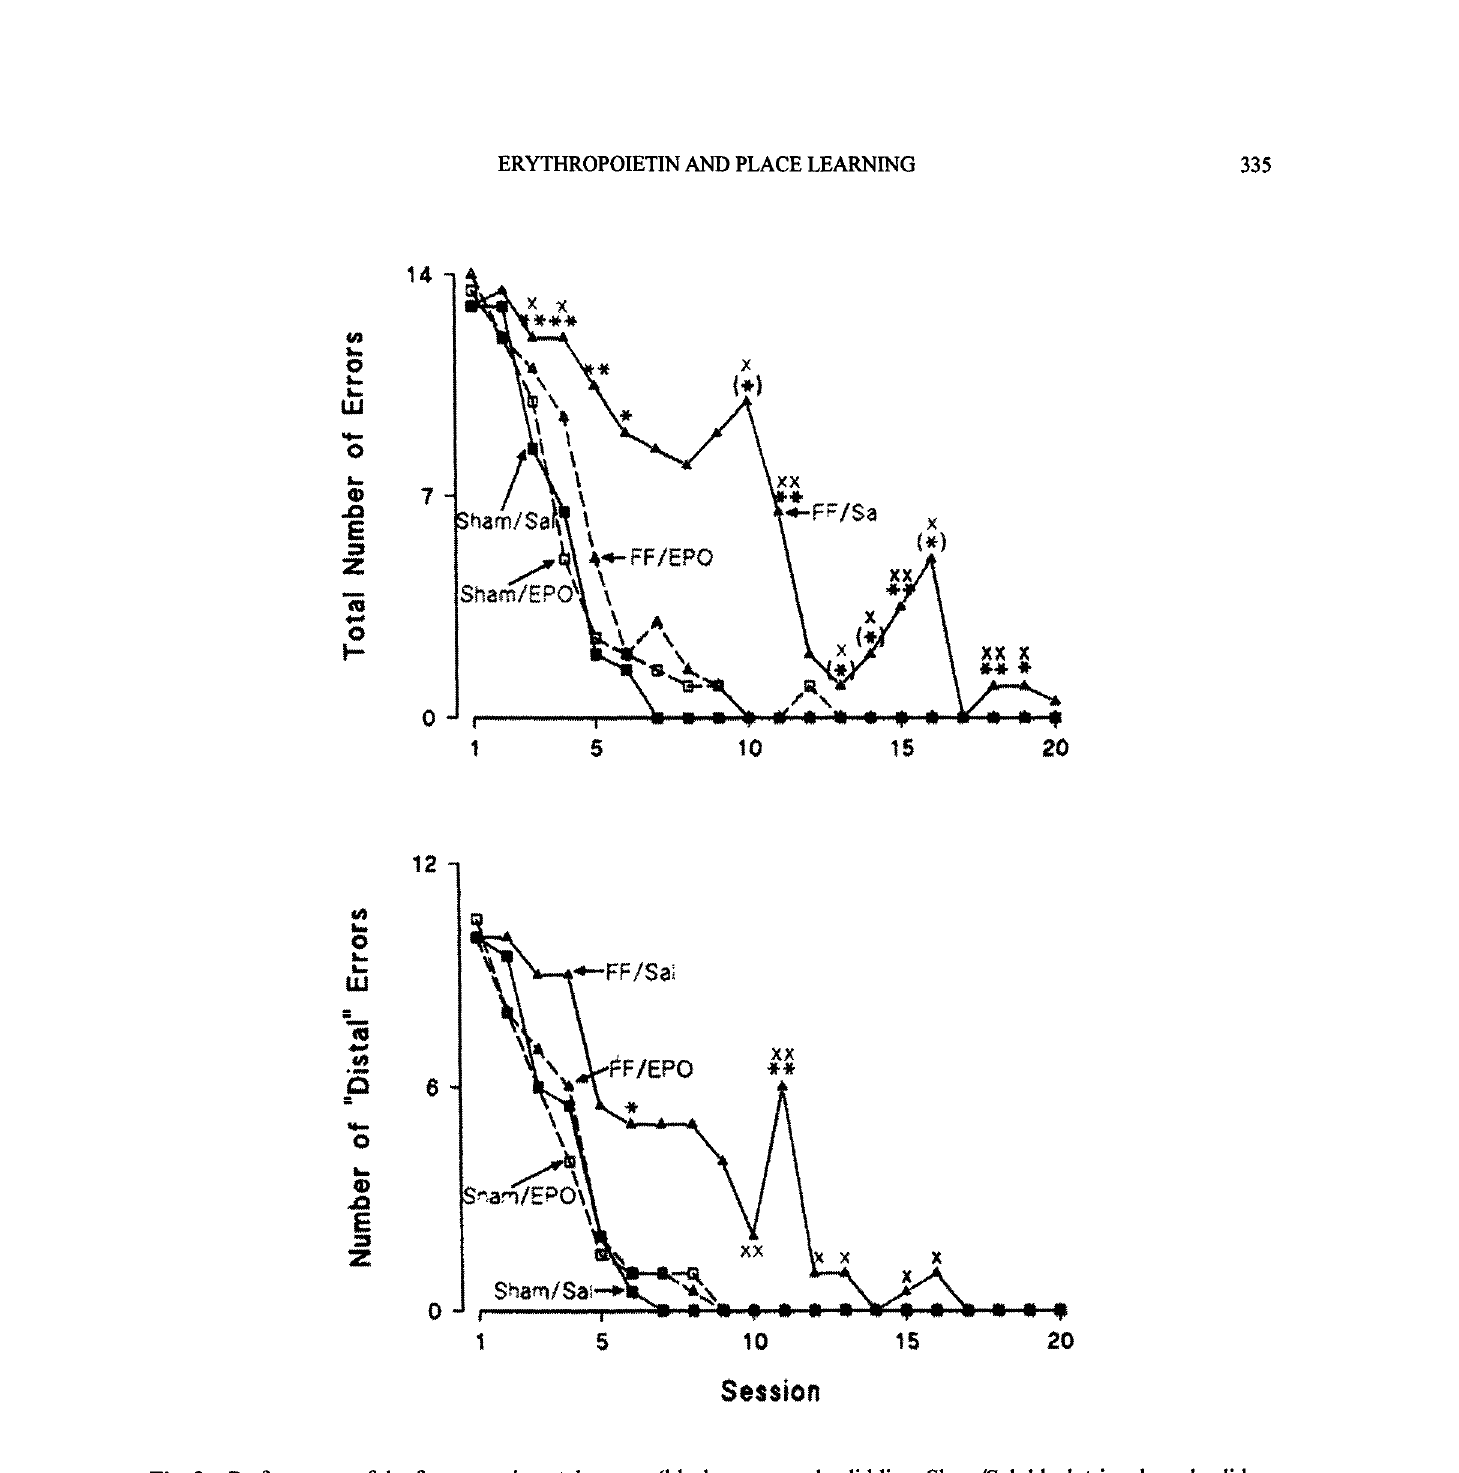
Fig. 2: Performance of the four experimental groups (black square and solid line: Sham/Sal; black triangle and solid line: FF/Sal; open square and broken line: Sham/EPO; open triangle and broken line: FF/EPO) on the 20 sessions of the place learning acquisition period. Values are given as medians. *: Significantly (p<0.05) different from the Sham/Sal group. (*): Significantly (p<0.05, one-tailed) different from the Sham/Sal group. **: Significantly (p<0.01) different from the Sham/Sal group, x: Significantly (p<0.05) different from the FF/EPO group, xx: Significantly (p<0.01) different from the FF/EPO